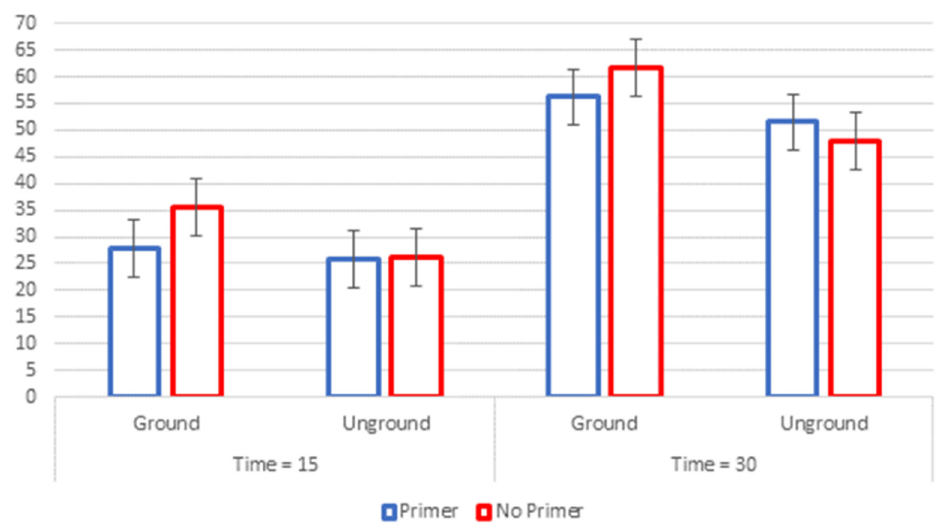
Figure 2. Group means comparison (vertical bars denote 95% confidence intervals).